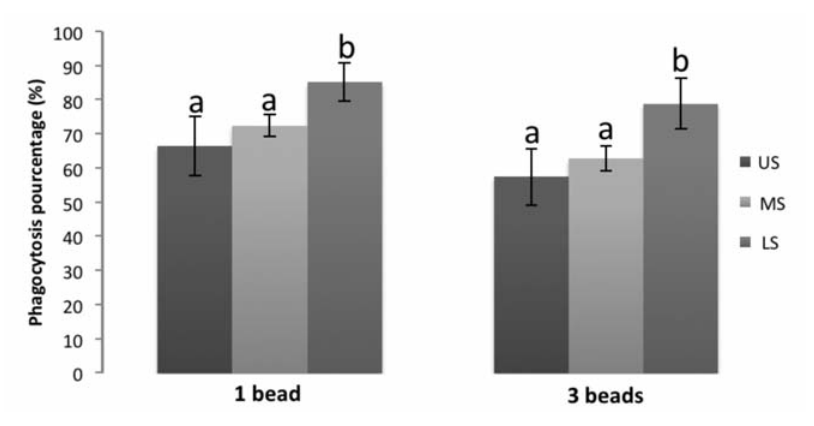
Figure 1. Phagocytosis activity (1 bead and more) and phagocytosis efficacy (3 beads and more) of Mya arenaria at upper shore (US), middle shore (MS) and lower shore (LS) from the site Jardins in Mitis Bay on July 31 st 2012